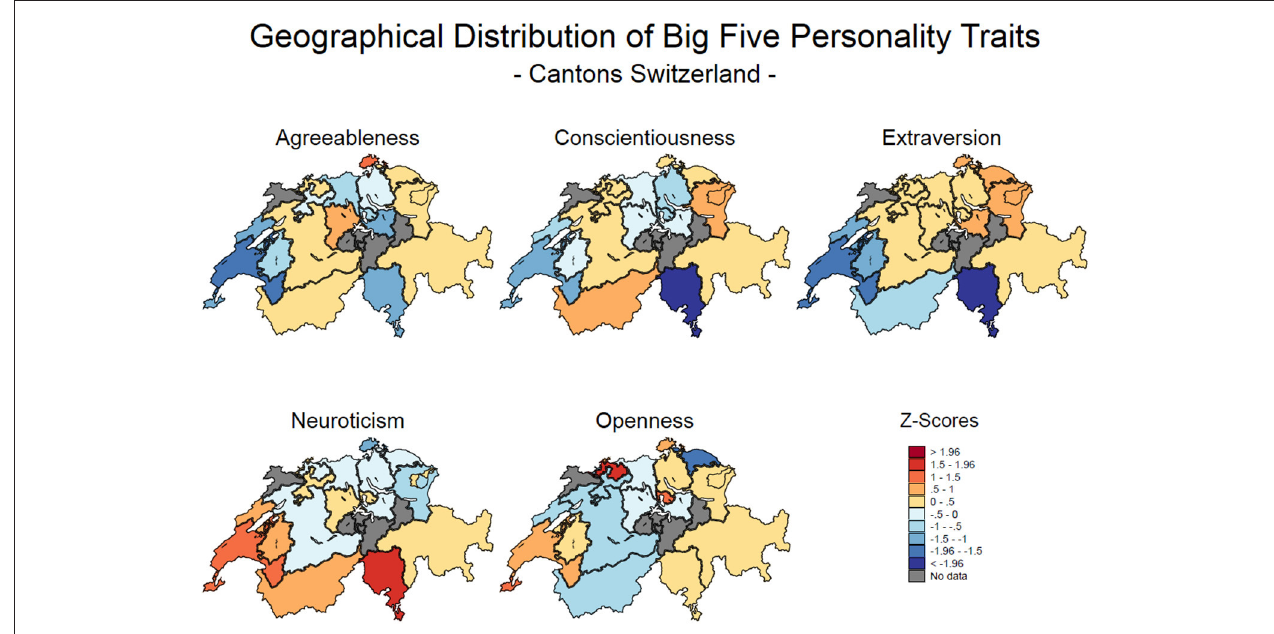
FIGURE 1 | Heat maps of the geographical distribution of personality in Switzerland by canton. For each personality trait, the areas in shades of blue are comparatively low and the areas in shades of red are comparatively